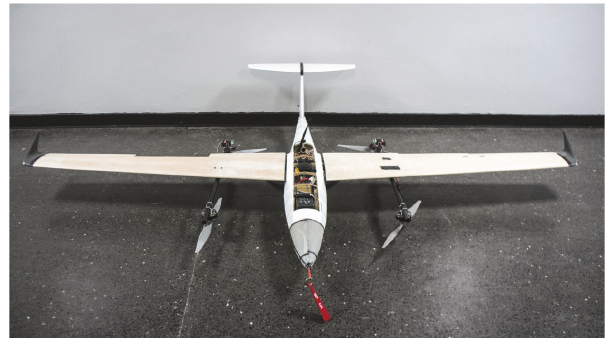
Figure 7: VTOL aircraft.